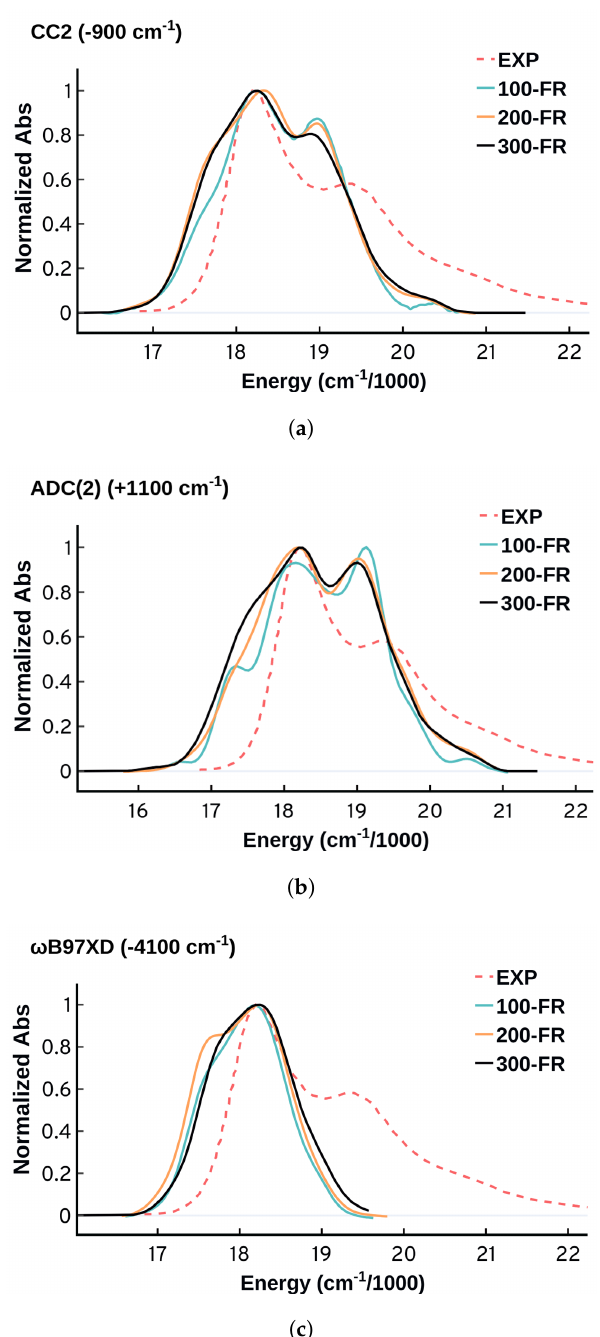
Figure 4. Comparing the spectra as a function of the number of configurations sampled (100 frames, 200 frames, 300 frames) obtained using ( a ) CC2, ( b ) ADC(2), and ( c ) ω B97XD. All the spectra have been normalized and shifted by the same shift as that used for the spectra obtained from 300 configurations to match the experimental maximum. The shift value and direction is included in parentheses in the charts